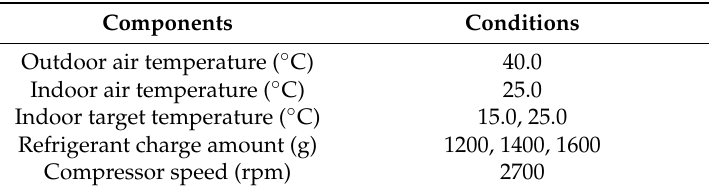
Table 2. Test conditions. rpm: revolutions per minute.